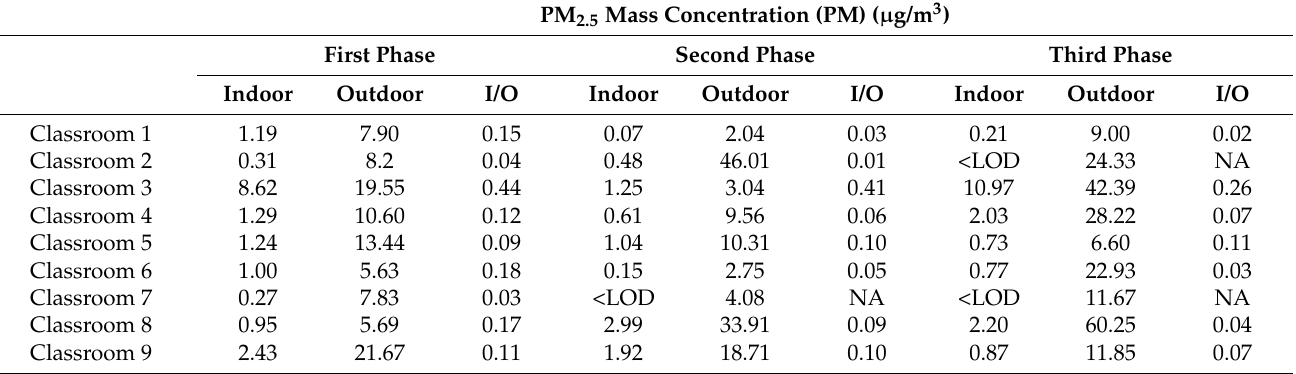
Table 2. Indoor, ambient, and indoor-to-outdoor (I/O) ratios of PM and PN in the three measurement phases. LOD refers to the limit of detection of the employed